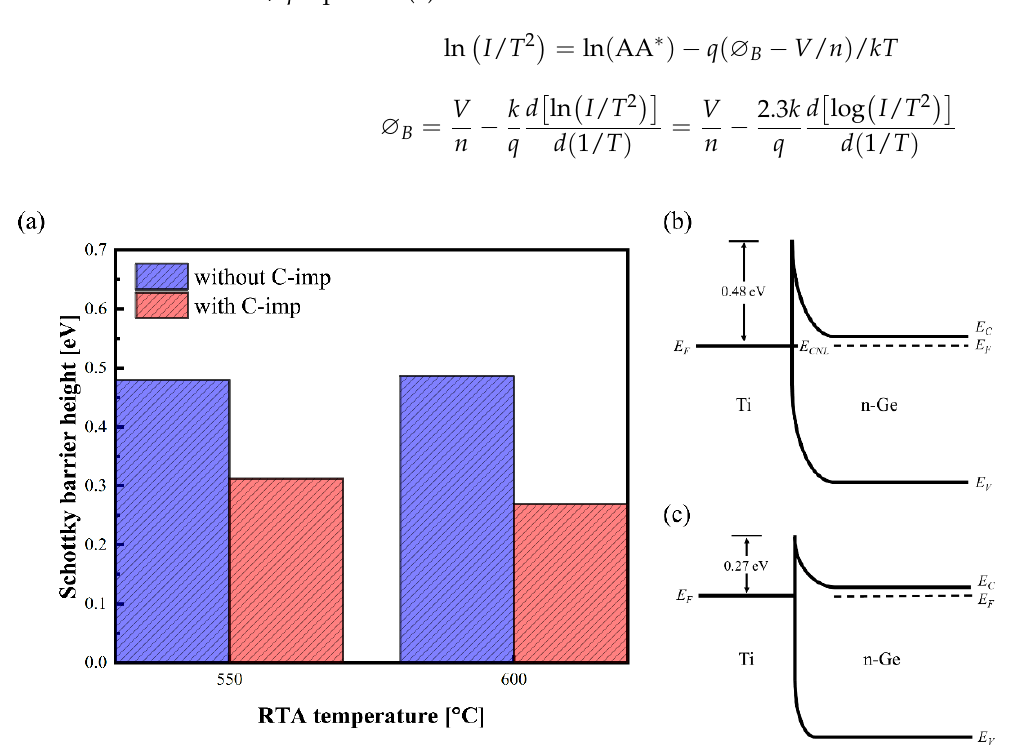
Figure 2. ( a ) e-SBHs of the Ti/Ge contacts without (blue box) and with (red box) C-imp after RTA at 550 °C and 600 °C for 60 s in N 2 ambient, respectively. Schematics of energy band diagrams for Ti/Ge contact ( b ) without and ( c ) with C-imp after RTA at 600 °C